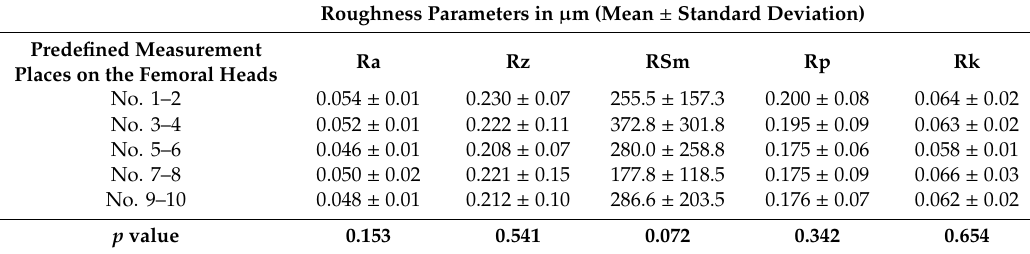
Table 4. Analysis of roughness parameters in the spacer group at the 5 predefined locations. Statistical significance is assumed for p < 0.05 and was not found.